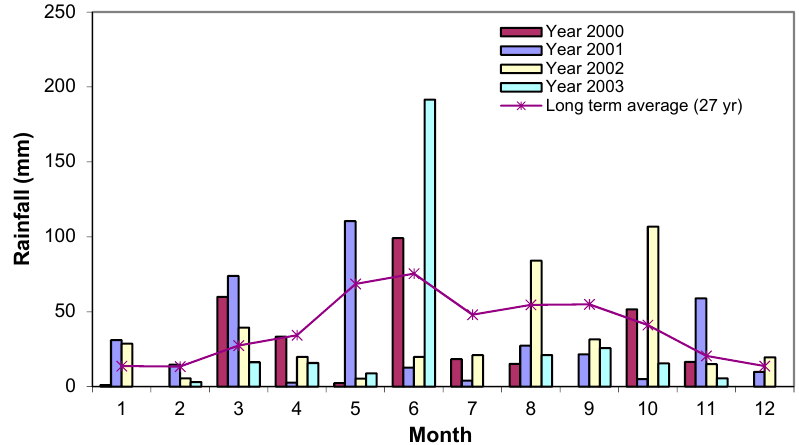
Figure 2. Monthly precipitation of 2000 to 2003 and long-term precipitation at Halfway, Texas.